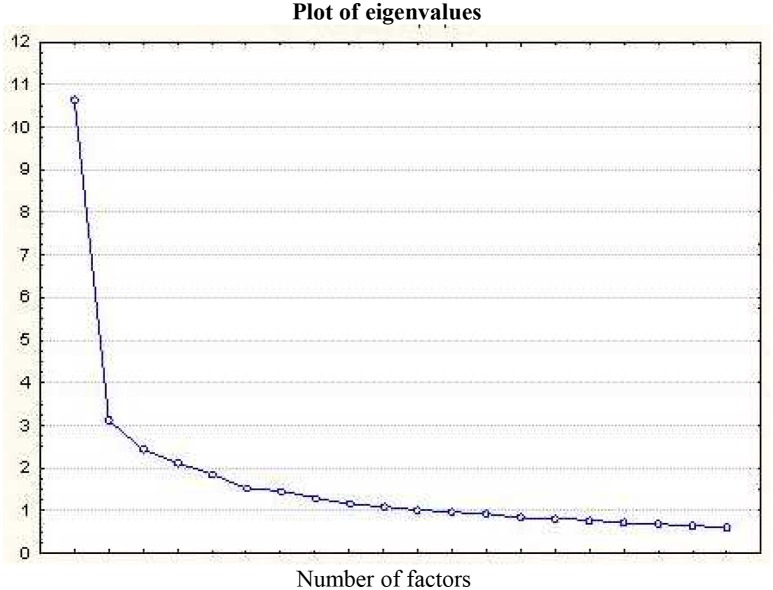
Plot of eigenvalues.